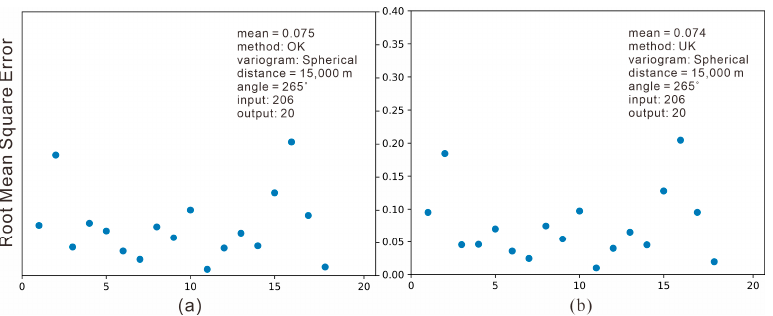
Figure A11. An additional test to compare the RMSE of different methods: ( a ) OK; and ( b ) UK. The mean RMSEs and parameters are listed in the top right-hand corner.